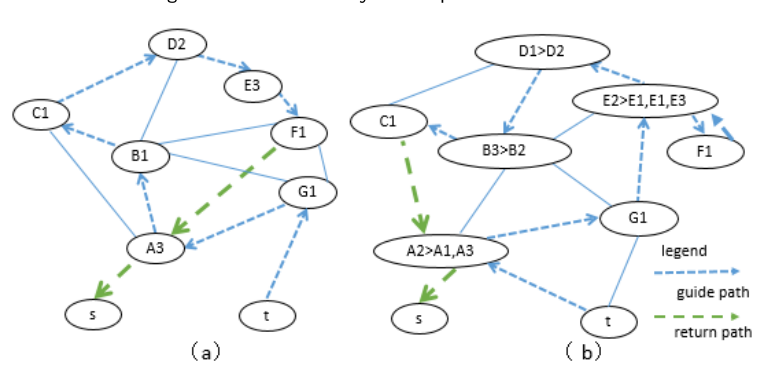
Fig. 5 Contrastive Analysis of Optimal Path from s to t